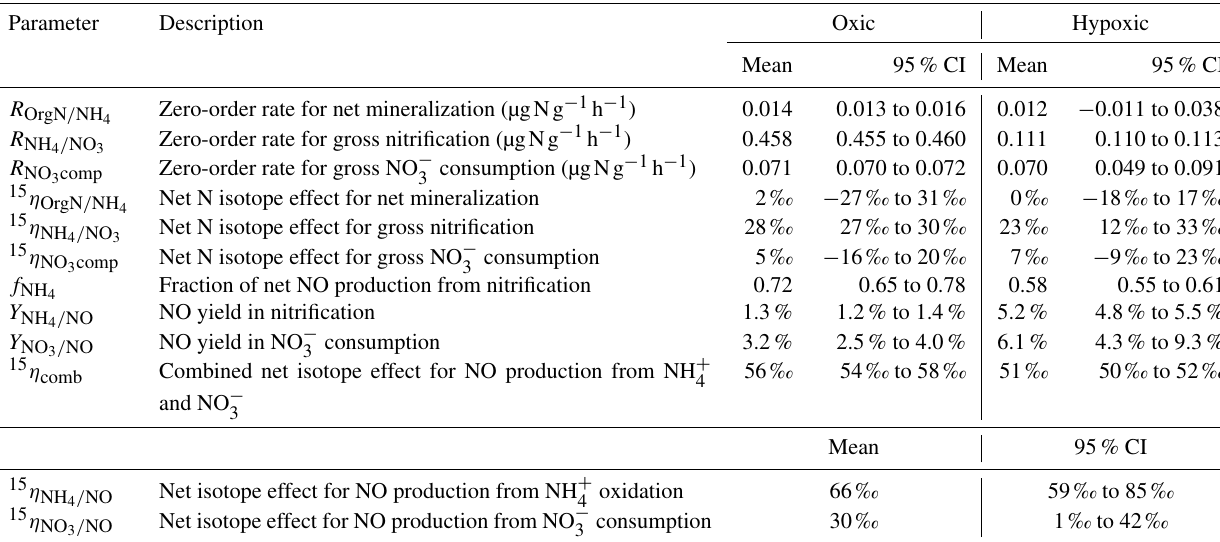
Table 2. Means and 95% confidence intervals of modeled gross N transformation rates, NO yields, and net N isotope effects in the oxic and hypoxic